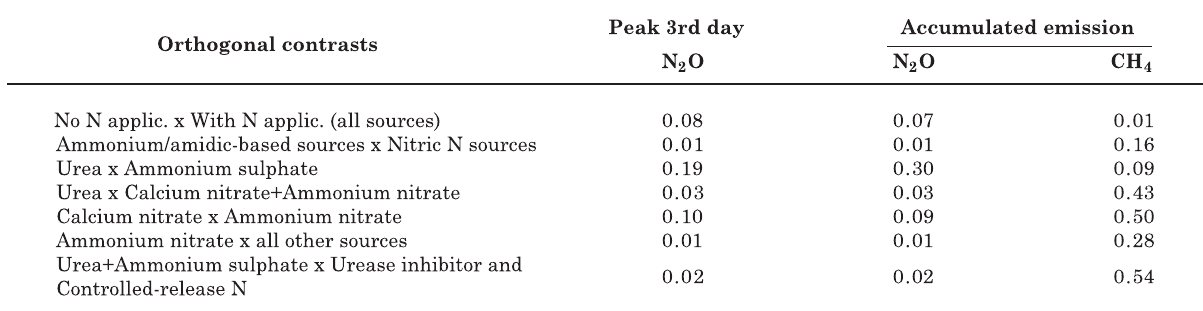
O and CH for the 15 day period and for the peak of N 2 4